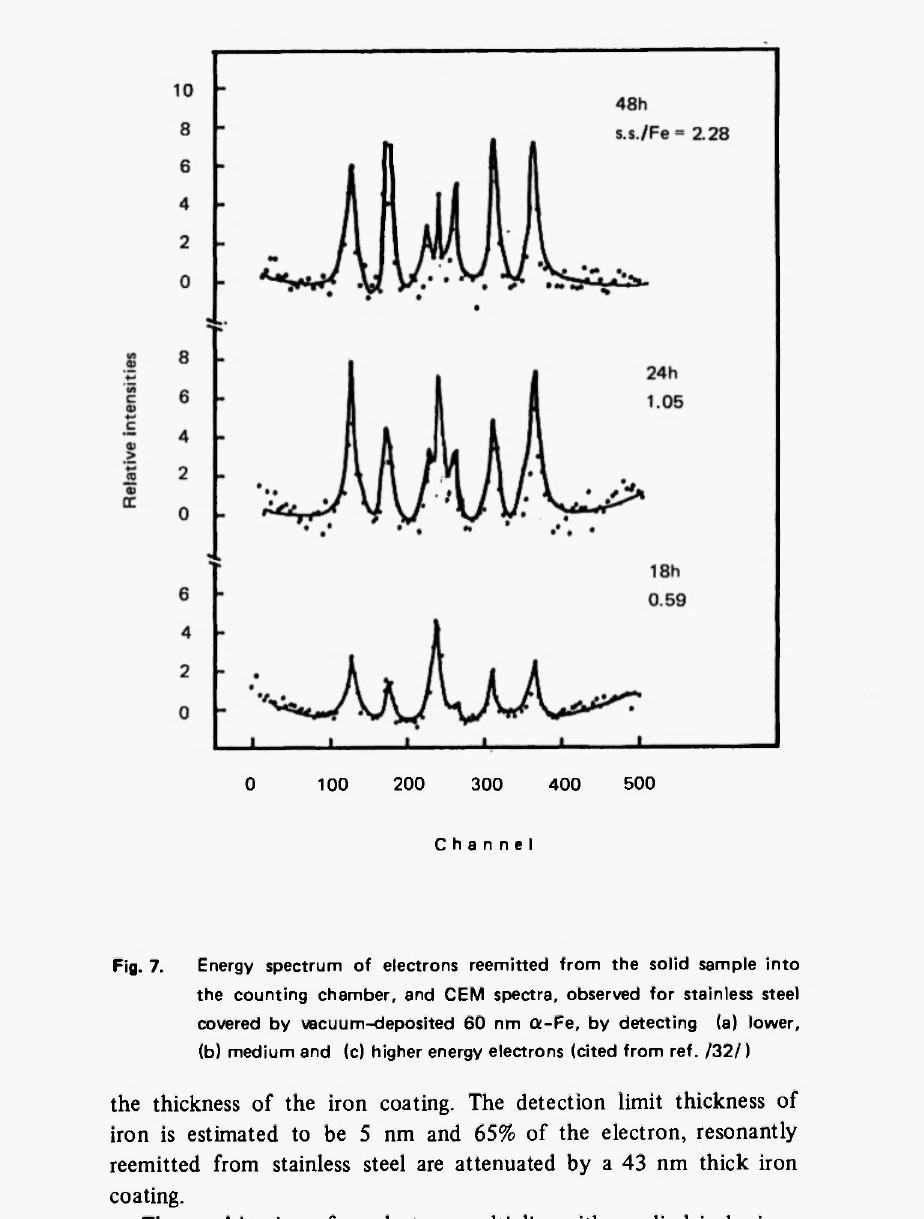
Fig. 7. Energy spectrum of electrons reemitted from the solid sample into the counting chamber, and CEM spectra, observed for stainless steel covered by vacuum-deposited 60 nm α-Fe, by detecting (a) lower, (b) medium and (c) higher energy electrons (cited from ref.